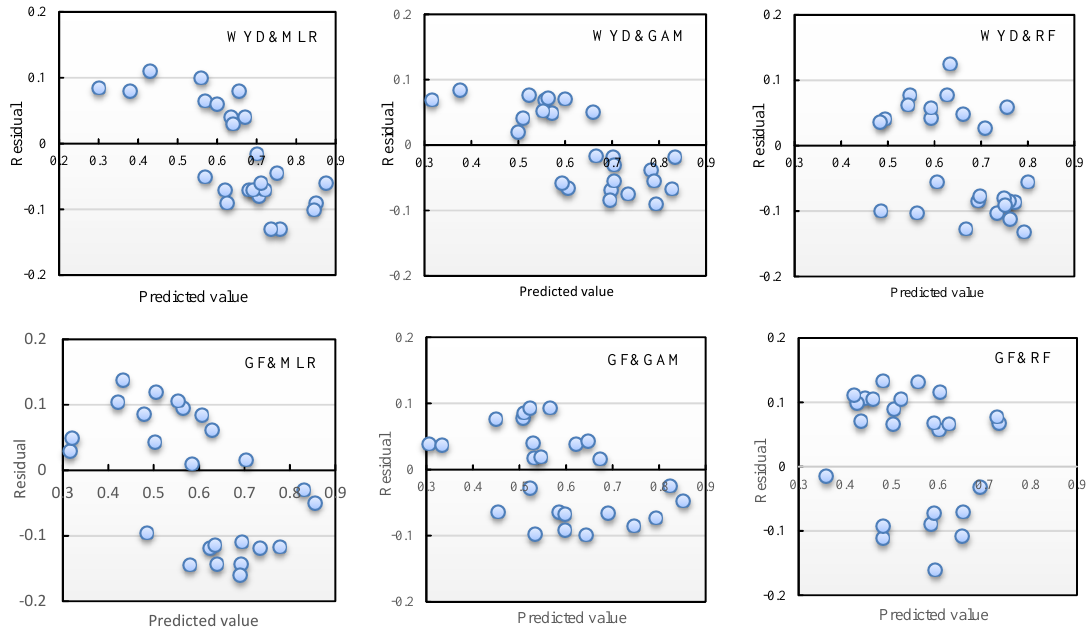
Figure 4. Residual diagram of canopy closure of two test areas estimated by three models. WYD—Wangyedian Forest Farm, MLR—Multiple Linear Regression, GAM—Generalized Additive Model, RF—Random Forest, GF—Gaofeng Forest